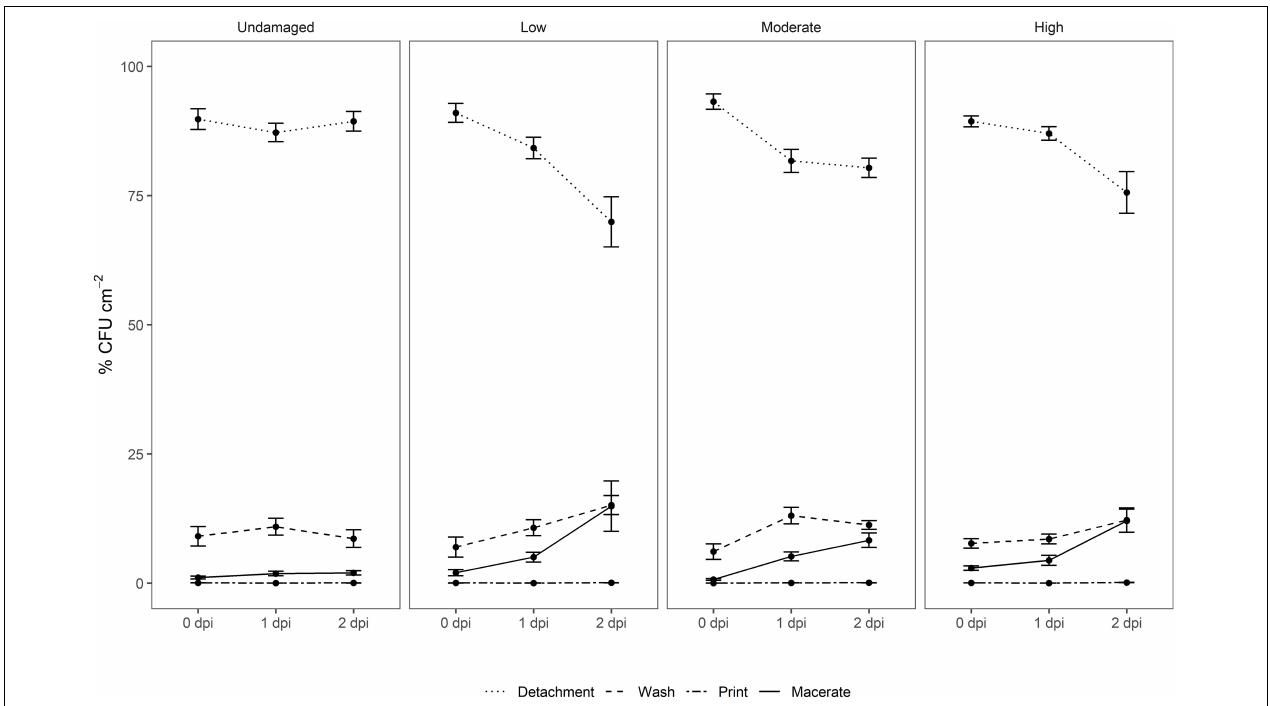
FIGURE 3 | Relative distribution of E. coli O157:H7 gfp + in suspensions after centrifugation (detachment, washing), after surface decontamination (leaf print), and in macerate of non-washed spinach leaves from a commercial leafy vegetable processing plant exposed to three levels of artificial damage (low, moderate, high) and leaves without intentional damage. Leaf analyses were performed directly after inoculation (0), and 1 and 2 days post-inoculation (dpi) of the target strain ( n =